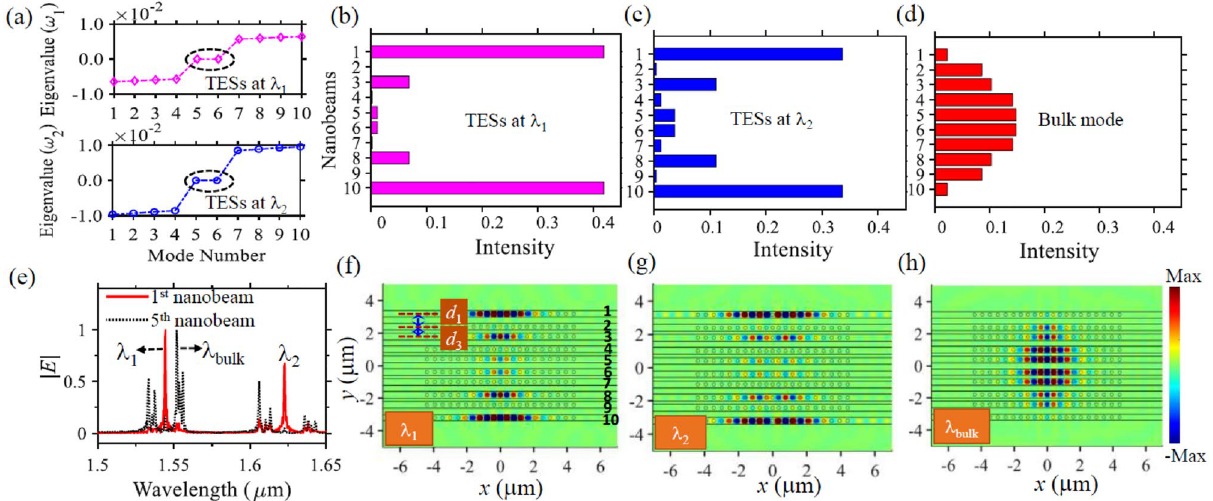
Figure 2. Generation of TESs with the finite SSH nanobeams implemented by the tight-binding model ( a – d ) and the 3D FDTD method ( e – g ). ( a ) The normalized eigenvalues of the first TES (upper) and the second TES (lower), indicating the existence of the two degenerated zero-energy TESs at both the first resonance wavelength (cid:31) (cid:31) ω ω 1 and the second resonance wavelength 2 . 1 and 2 are the angular frequency of the two TESs with respect to (cid:31) (cid:31) 1 and 2 respectively. The field distribution (i.e., the real part of the eigenvectors) of these TESs have localized field at edge nanobeams in symmetric or antisymmetric manners, as plotted in Fig. S4 in Supplementary Information. ( b – d ) The conventionally normalized intensity (i.e., the absolute value of the eigenvector) of the TESs at (cid:31) 1 , (cid:31) 2 , and one of the bulk modes, respectively. ( e ) The normalized | E | spectra of the edge nanobeam (i.e., the 1st nanobeam) and the middle nanobeam (i.e., the 5th nanobeam) of the SSH structure. The first (fifth) nanobeam has the same spectra to that of the tenth (sixth) nanobeam due to structure symmetry. ( f – h ) The real part of the field distribution H z of the first TES at (cid:31) 1 = 1.546 µ m , the second TES at (cid:31) 2 = 1.624 µ m , and the bulk mode at (cid:31) bulk = 1.552 µ m in the middle plane of the nanobeam membrane, respectively. The SSH structures under study have 10 identical nanobeams with alternative neighboring distance of d 1 = 0.8 µ m and d 3 = 0.6 µ m , and zero axial shift (i.e., d 2 = 0 µ m ), as denoted by the structure outline in ( f ). Each nanobeam of the SSH structure has geometrical parameters same as those in Fig.